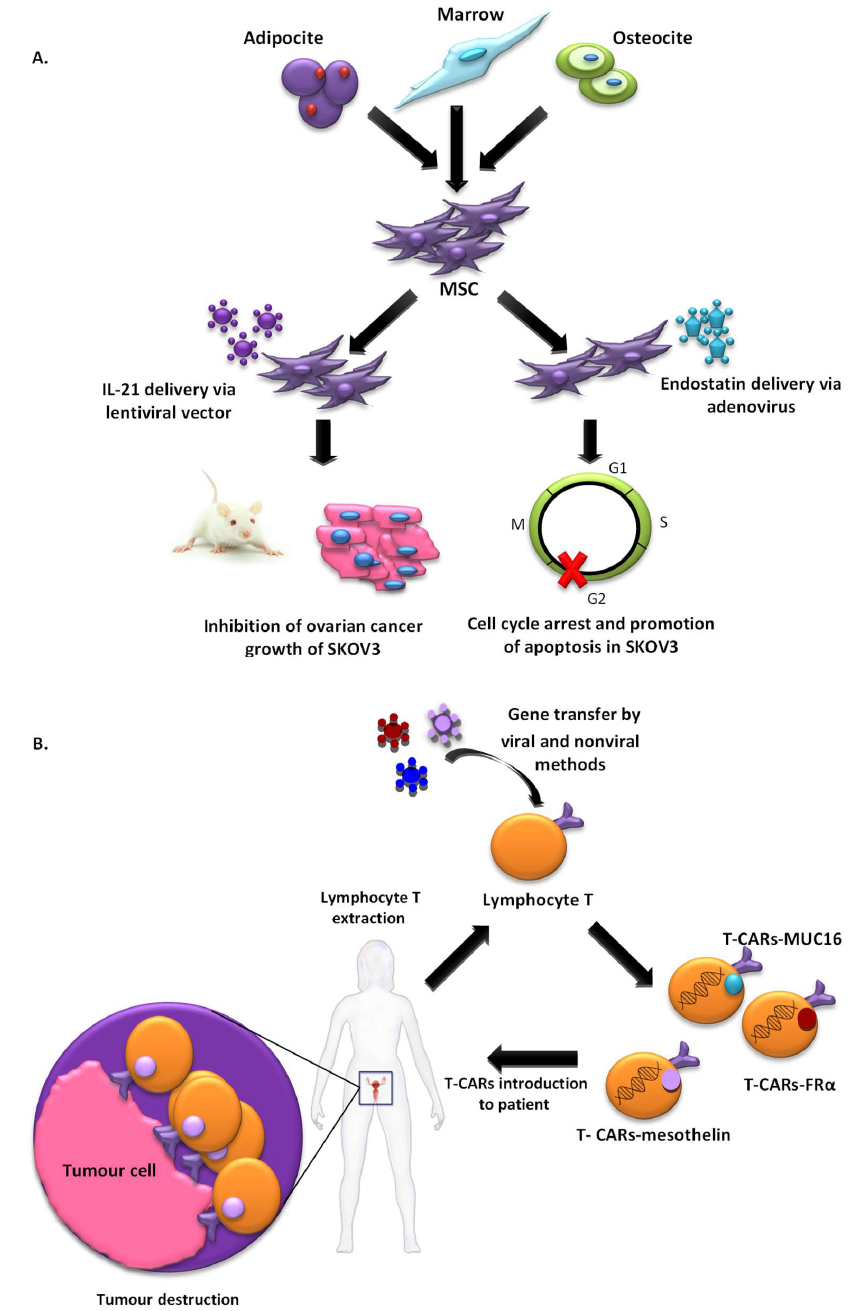
Figure 2. Summary of current therapies targeting ovarian cancer through the use of cell-based vectors. ( A ) MSCs as vehicles for drug delivery; ( B ) reprogramming the T cells of patients to express CARs targeting ovarian cancer.